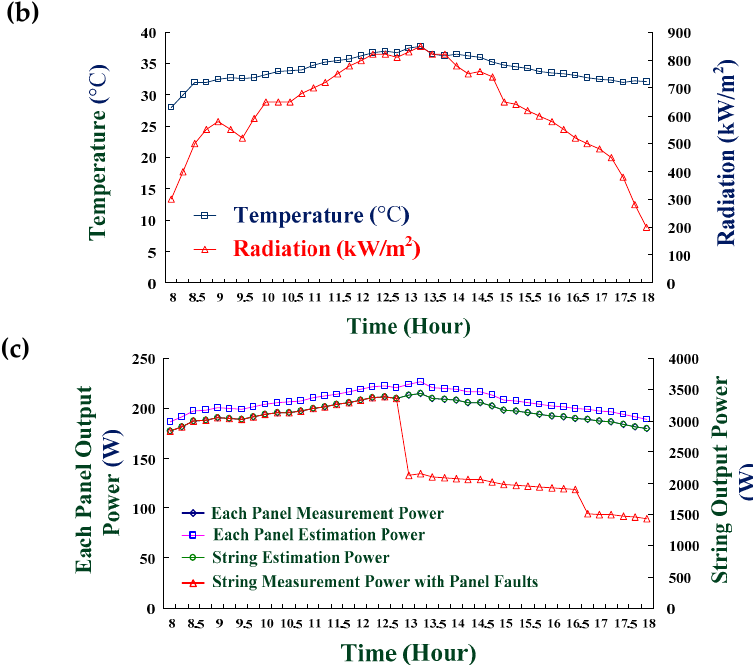
Figure 7. Experimental setup. ( a ) Schematic diagram of a rooftop PV system, consisting of 2 strings with 16 PV panels; ( b ) Solar radiation and temperature versus time (from 8:00 a.m. to 18:00 p.m.); ( c ) Each PV panel and string measurement power and estimation power.